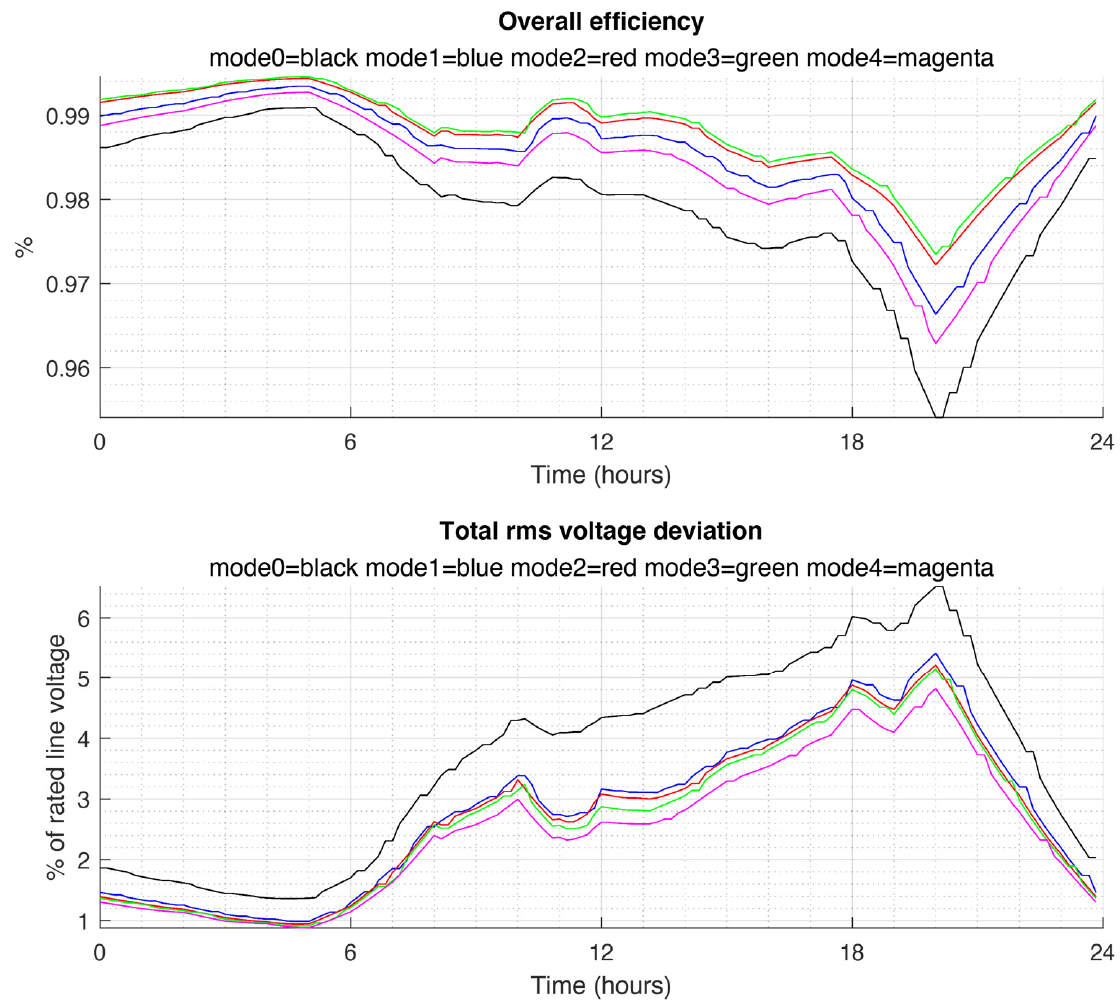
Figure 7. Effect of control methods on the overall efficiency and RMS voltage deviations.